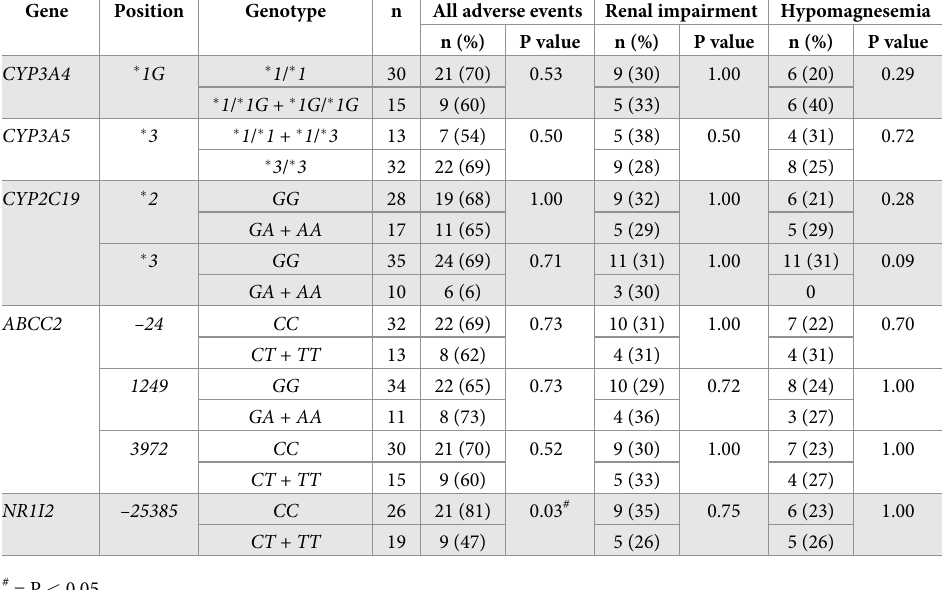
Table 6. Association between gene polymorphisms and adverse